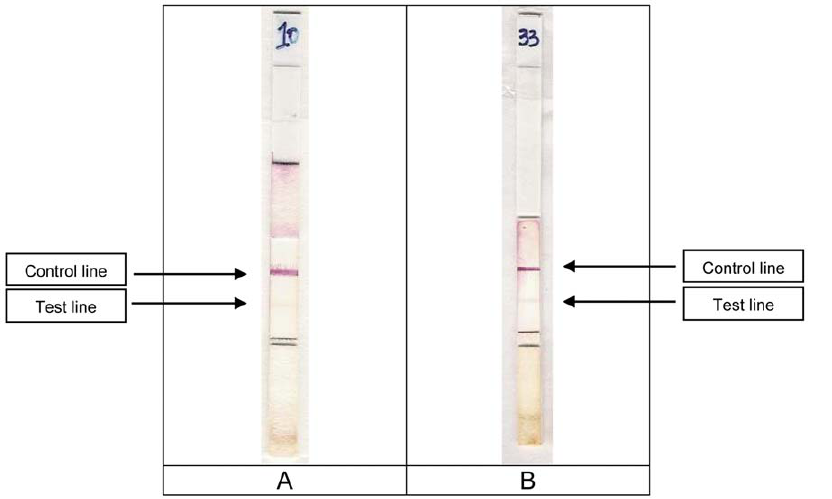
Figure 2. Two dipsticks showing a negative reaction with a faint yellow band appeared before or after the optimal time of 10 minutes to read the test (A) and after drying (B).